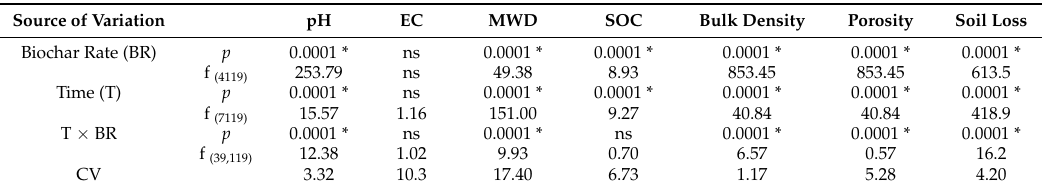
Table 3 . Summary of analysis of variance for various parameters analysed. Table 3. Summary of analysis of variance for various parameters analysed.